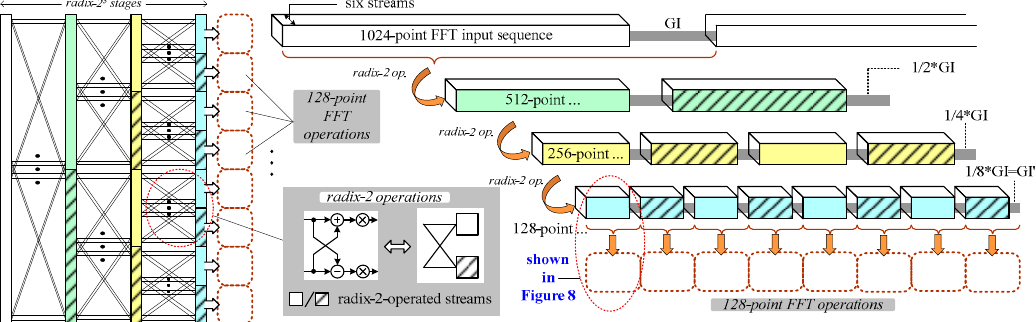
Figure 7. Operation flow for the generation of 128-point FFT block based on 1024-point MDF FFT.